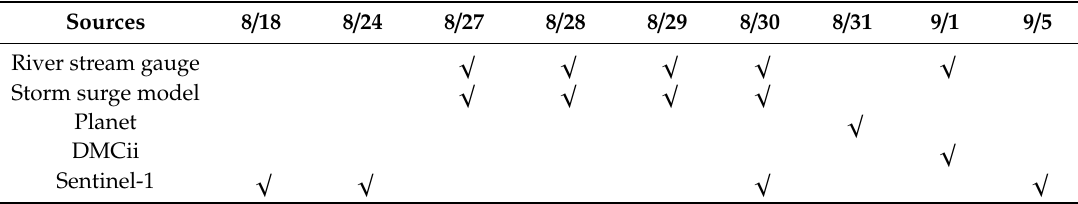
Figure 7. Remotely sensed data from SAR ( a , b ) and optical ( c , d ) sensors. Table 1. Available dates for different information sources.